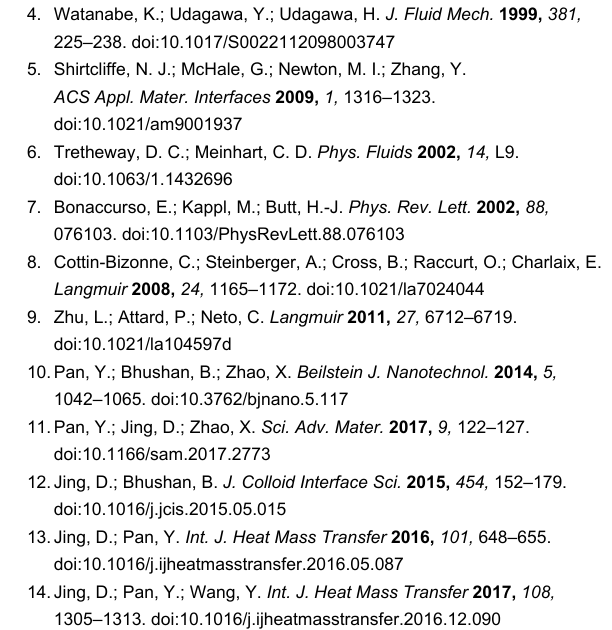
Figure 9: Hydrodynamic force F hydro and V / F hydro of a borosilicate sphere on superoleophobic surfaces b1 to b5 immersed in ethylene glycol with varying values of RMS roughness at a sphere velocity of 38.5 μ m/s.